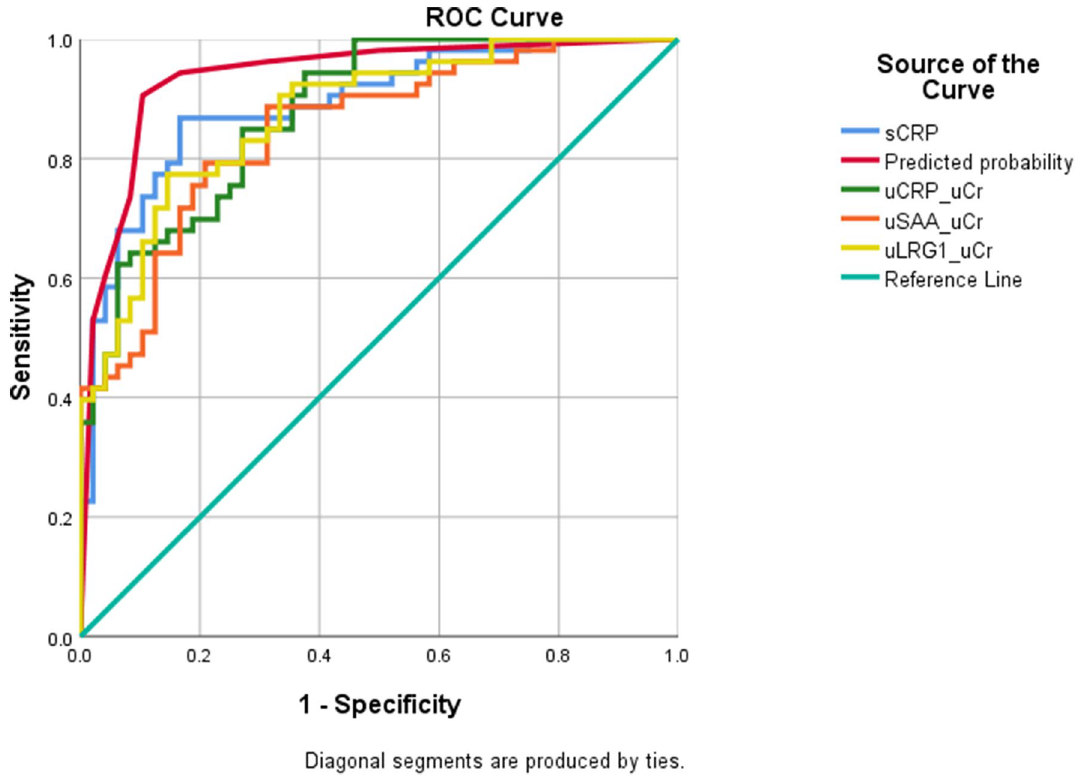
Figure 3. The ROC curves of adjusted concentration, s-CRP and predicted probability.